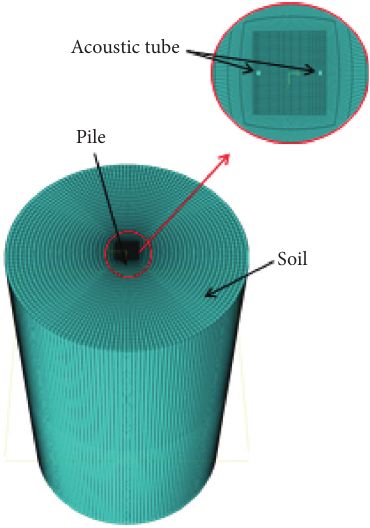
Figure 2: The meshing of the